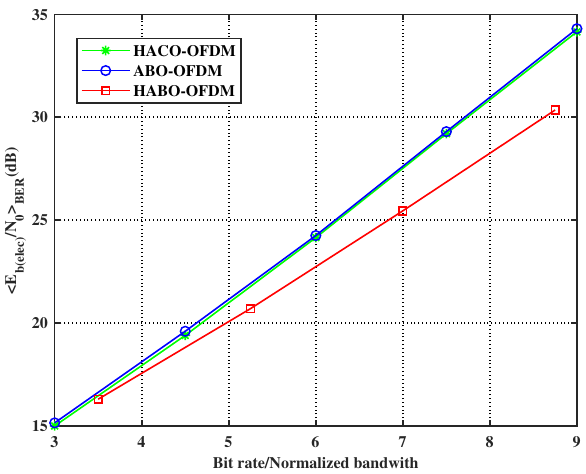
Figure 8. (cid:104) E b ( elec ) / N 0 (cid:105) BER required for the BER target of 10 − 3 versus Bit rate/Normalized